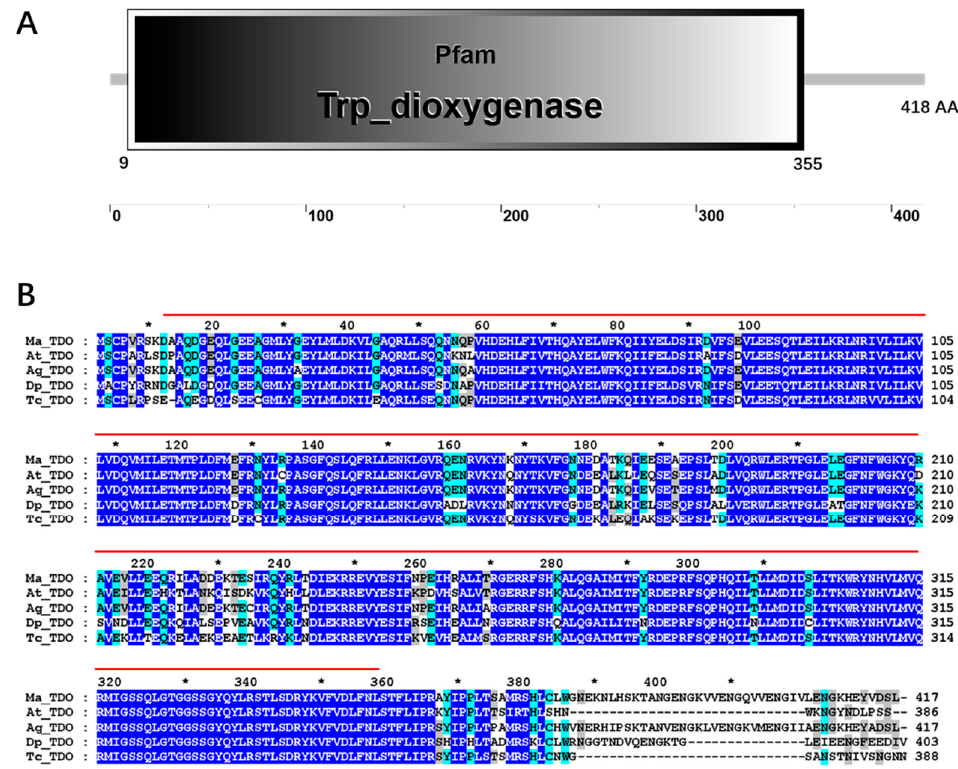
Figure 2. Conserved domains of the tryptophan 2,3-dioxygenase (TDO) protein in Monochamus alternatus and comparison to the domains of other insects. ( A ) Trp_dioxygenase domain of the TDO protein. ( B ) Multi alignment of TDO protein sequences in Tribolium castaneum (NP_001034499), Anoplophora glabripennis (Asian long-horned beetle; XP_018573815), Nicrophorus vespilloides (Boreal carrion beetle; XP_017783763), Aethina tumida (small hive beetle; XP_019868462), and Dendroctonus ponderosae (mountain pine beetle; XP_019756918). Residues that are completely conserved are in sapphire blue. Identical residues are in cyan. Similar residues are in gray, and different residues are in white. The TDO domain is indicated by the red line above the sequence.